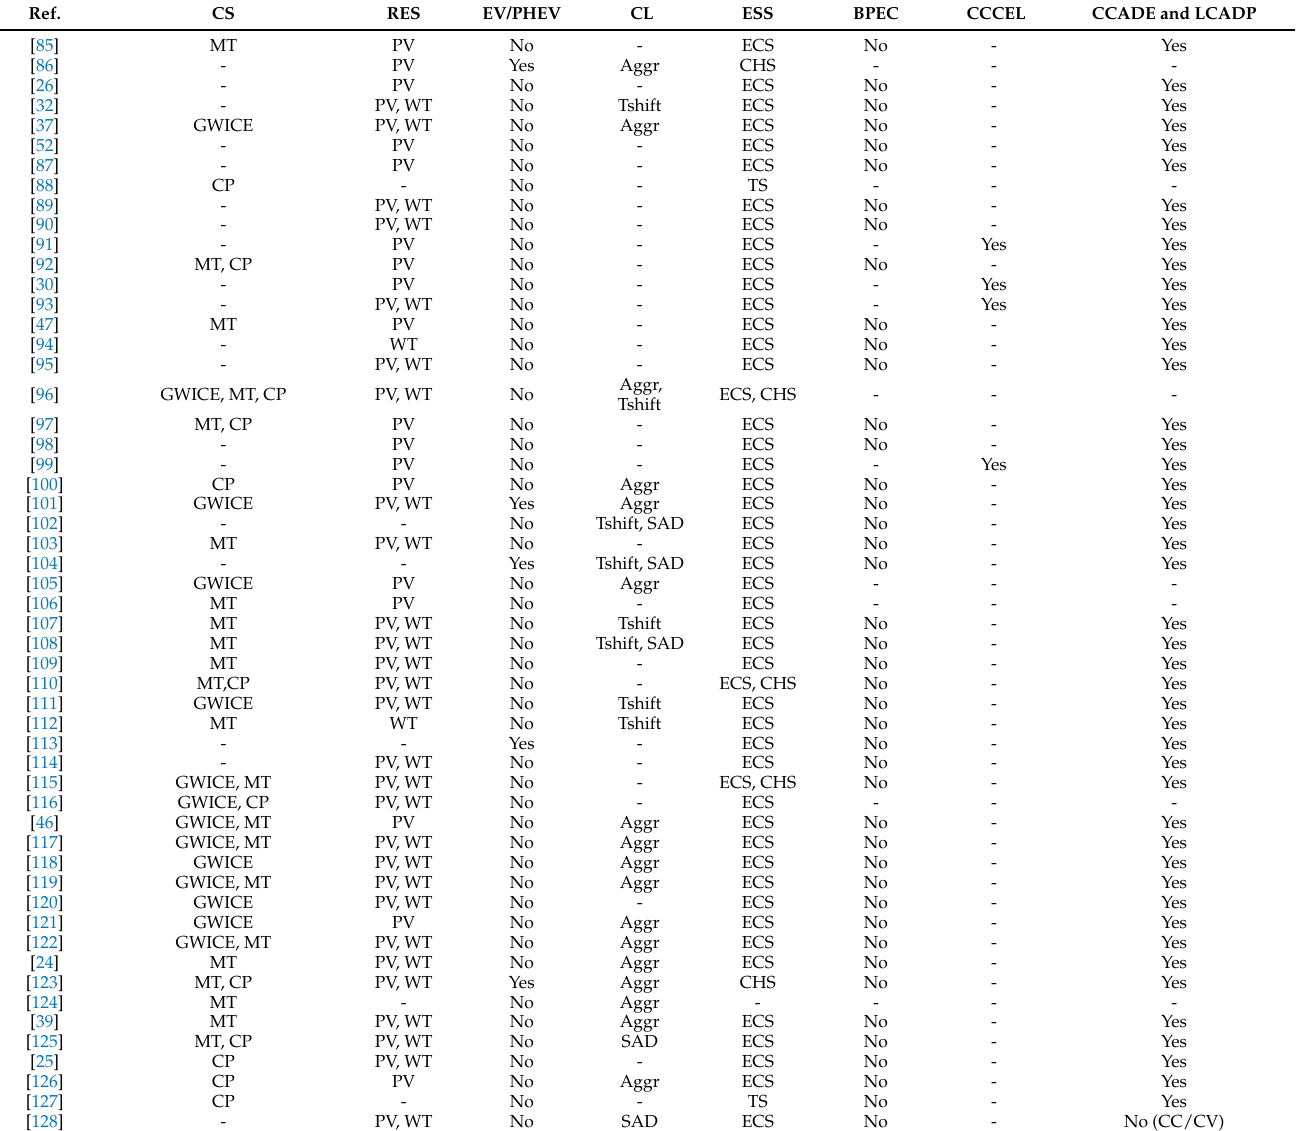
Table 1. Review of the scientific literature with respect to types, elements and modeling of the power electronics converter of